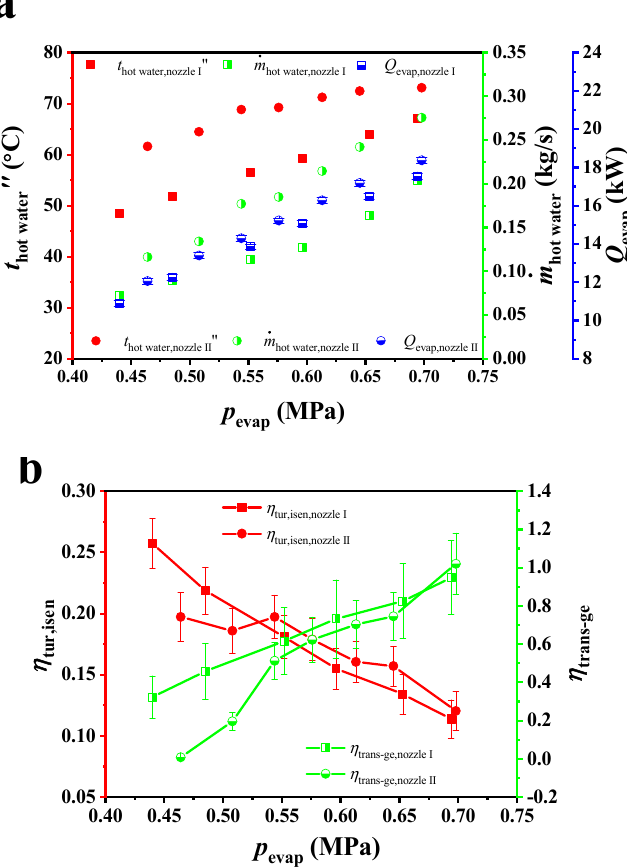
Figure 4. Variation of system performance with evaporating pressure (R245fa). ( a ): Parameters about the hot water; ( b ): Efficiency about the turbine and the generator.